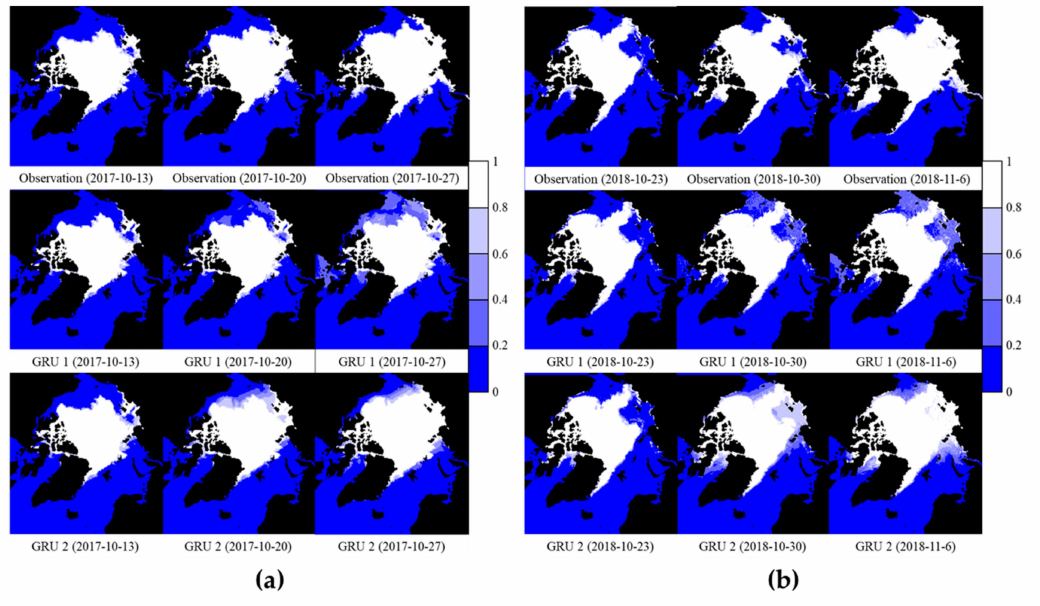
Figure 10. Development of SIC: ( a ) Period 20; ( b ) Period 45.